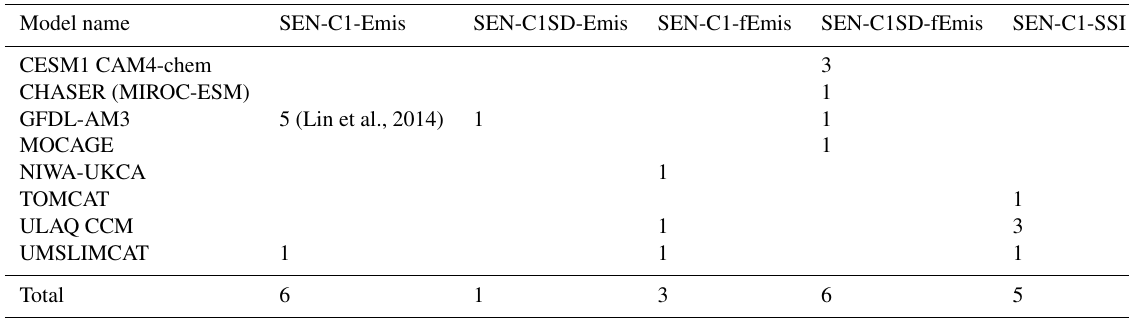
Table 5. SEN-C1 sensitivity simulations, by model.